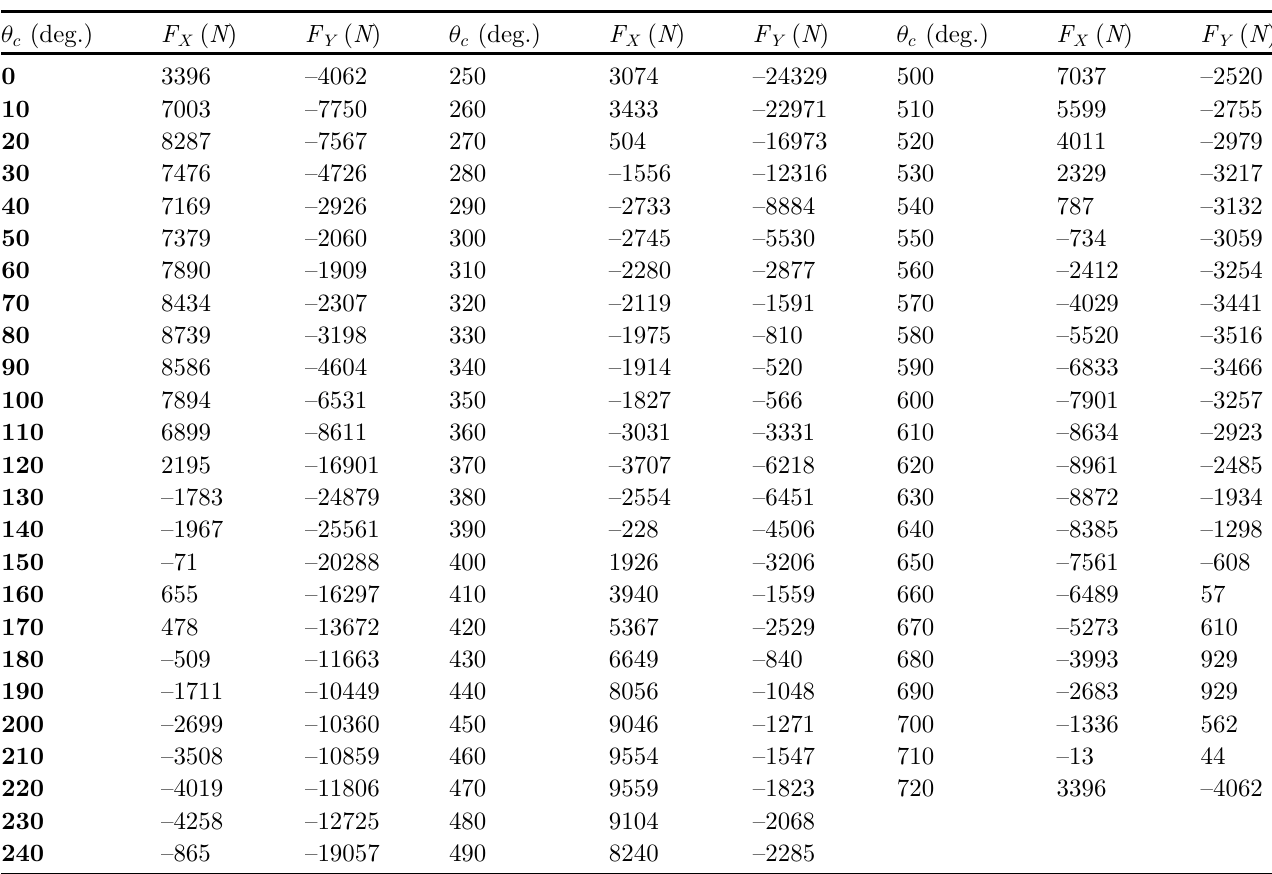
Table 2. Numerical values of the dynamic loading on the crankshaft main bearing for one engine cycle at 5000 rpm [47,48]. u c (deg.)